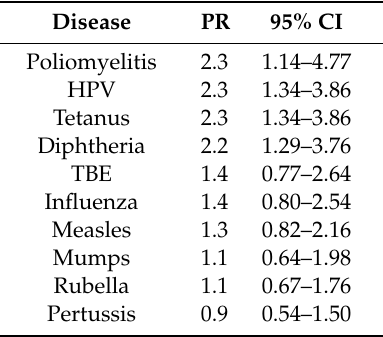
Table 4. Association (prevalence ration (PR) and 95% confidence interval (95% CI)) between the perception of the severity of disease and having been classified as